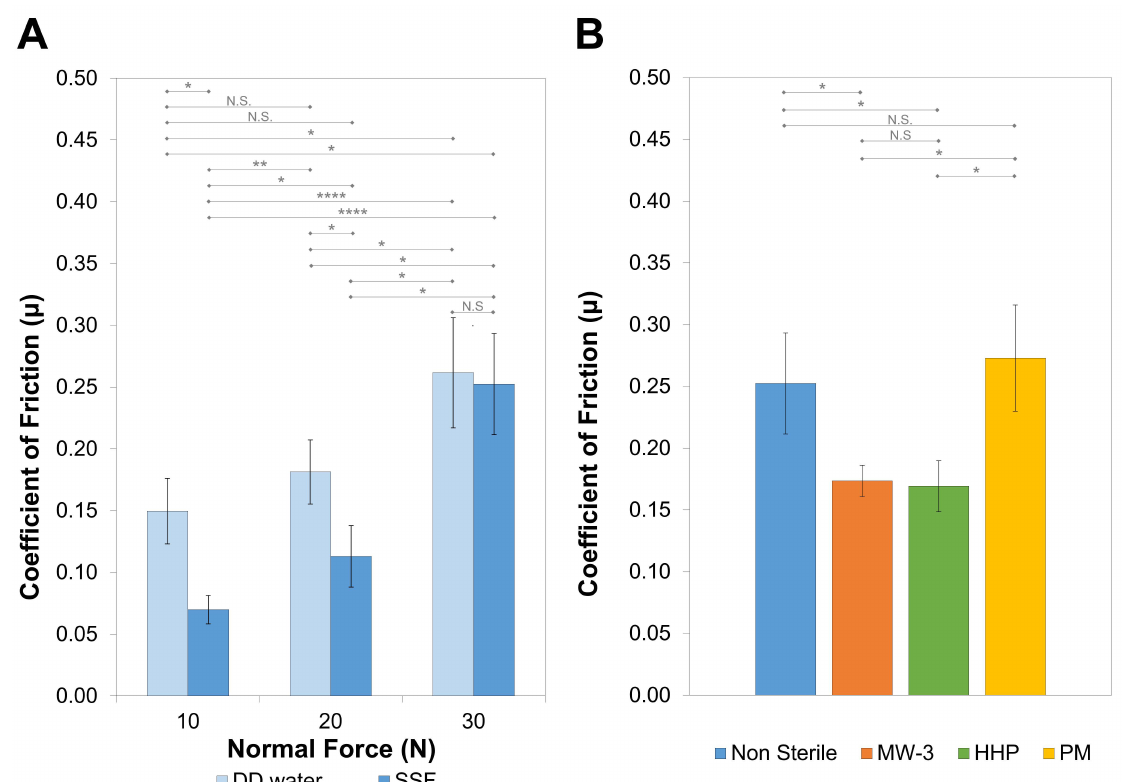
Figure 9. Coefficient of friction values for the non-sterile PVA/PBO hydrogels at different applied loads, using DD water and SSF as lubricants ( A ), and of the non-sterile and sterile hydrogels with 30 N of normal load and SSF as lubricant ( B ). Porcine cartilage was used as the counter body. The error bars represent the mean ± standard deviations ( n = 3). Statistical analysis was performed using a Student- t test, with significance set at * p < 0.05, ** p < 0.01, **** p < 0.001. N.S. = not